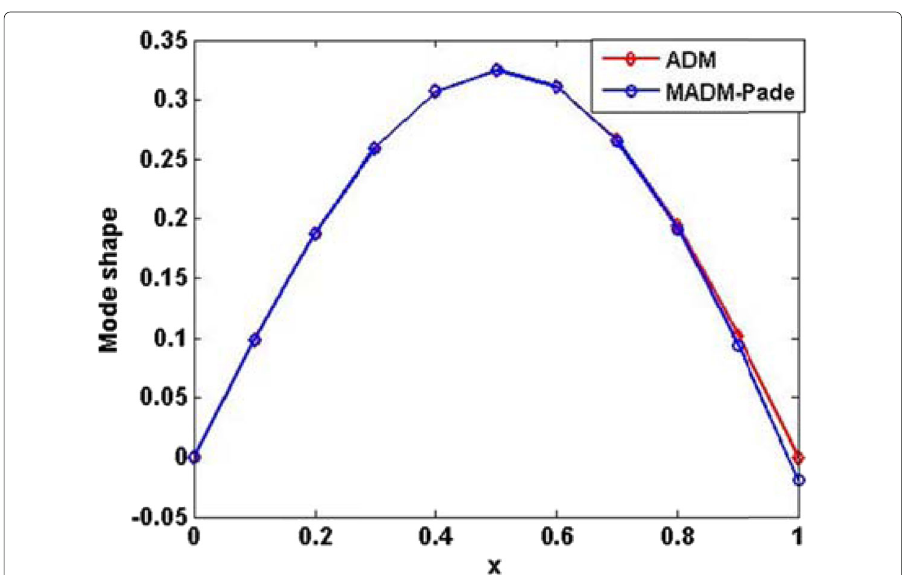
Fig. 3 Application of Laplace Padè approximant on